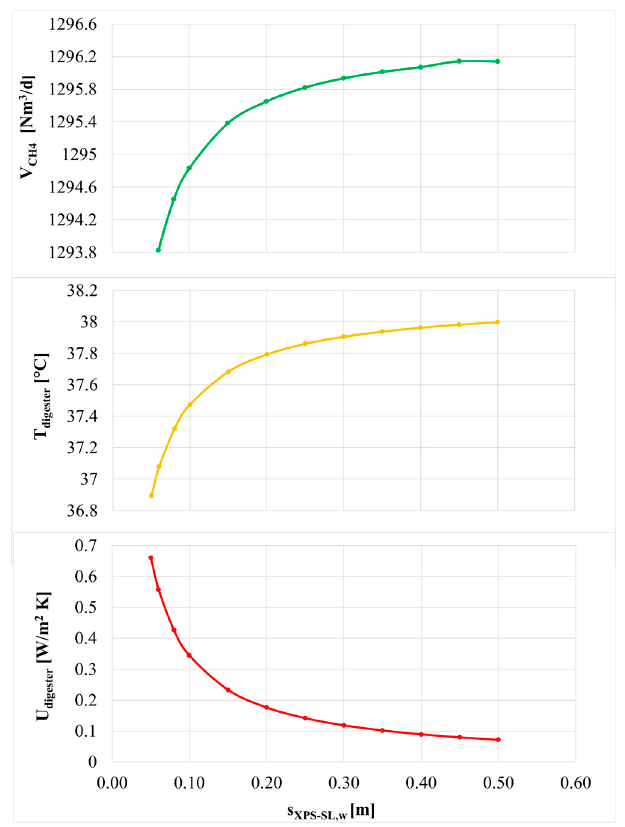
Figure 10. Influence of insulation thickness on U digester value, operating temperature and biogas production.